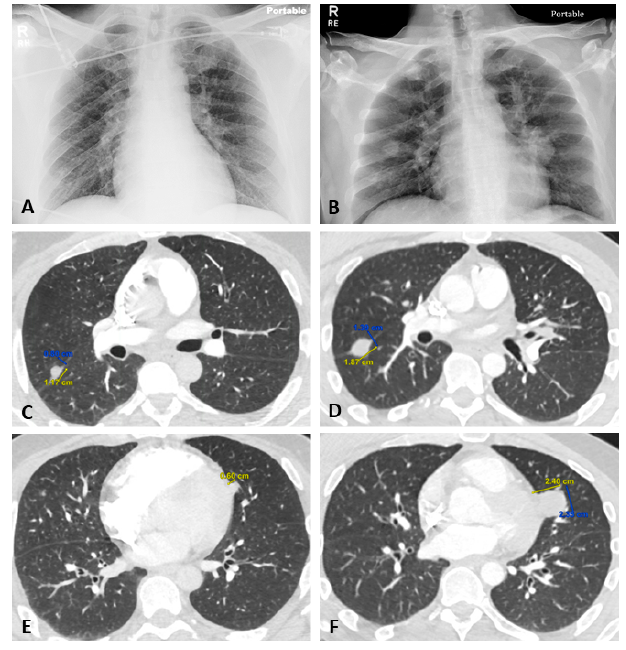
Figure 1. Imaging studies of the chest demonstrate increasing size of bilateral nodules between initial identification ( A , C , E ) and one month time interval ( B , D , F ). A-B, Chest x-ray. C-D, Right oblique fissure nodule visualized on computerized tomography (CT). E-F, Left upper lobe subpericardial solid nodule visualized on CT.